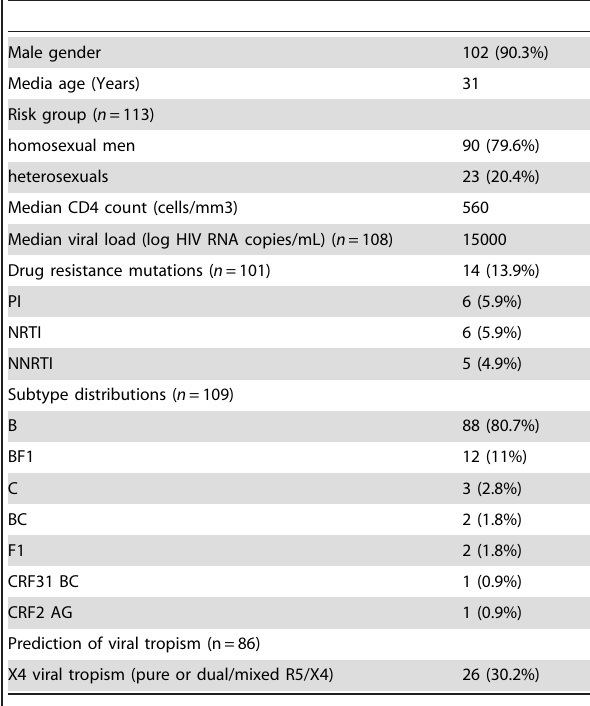
Table 1. Characteristics and main findings of the Brazilian HIV-1 recently infected